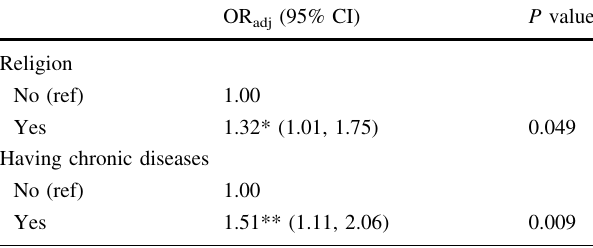
Table 5 Summary of multivariate logistic regression for no specific temperature to turn on cooling devices in the risk perception of